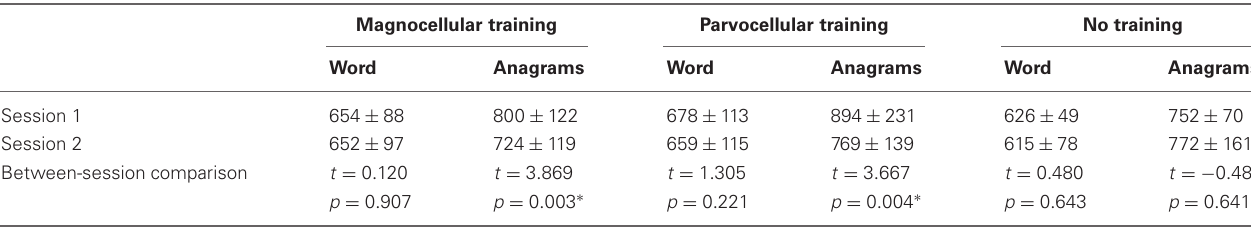
Table 2 | Mean reaction time ( ± SD) on a lexical decision task by type, group, and session.